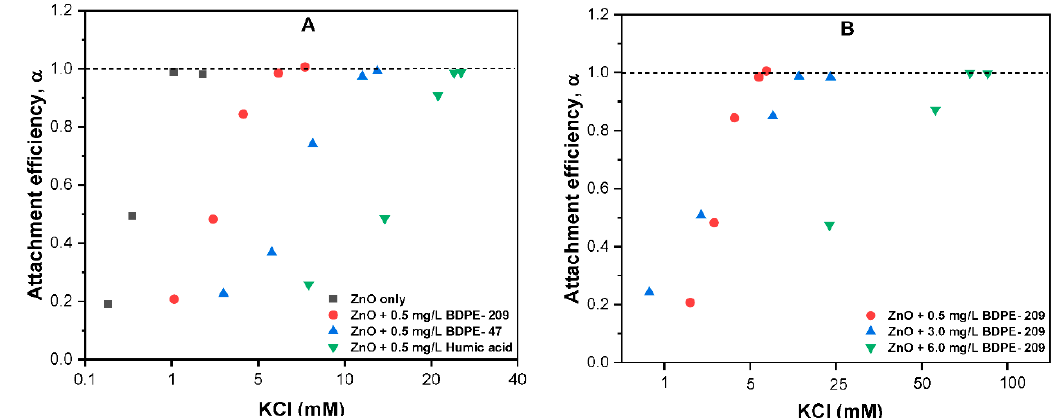
Figure 6. ( A ) Effects of 0.5 mg/L BDPE 47, BDPE 209, and humic acid (HA) on the critical coagulation concentration (CCC) of KCl, and ( B ) effects of different concentrations of BDPE-209 on the CCC of KCl for ZnO NPs (10 mg/L) at pH 7.